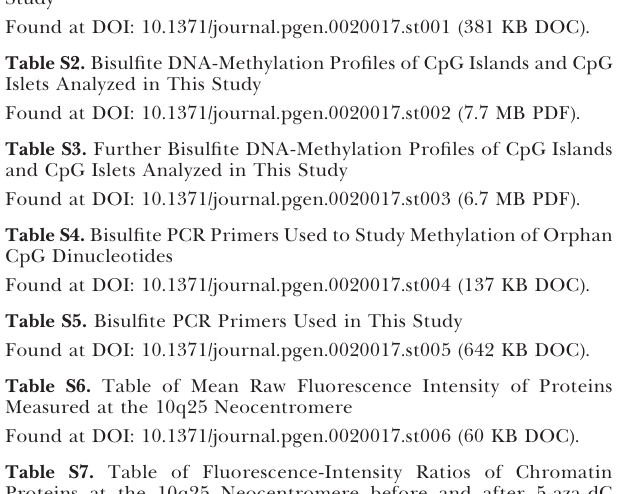
Table S1. Table of Control CpG Islands and CpG Islets Used in This Study Table S2. Bisulfite DNA-Methylation Profiles of CpG Islands and CpG Islets Analyzed in This Study Table S3. Further Bisulfite DNA-Methylation Profiles of CpG Islands and CpG Islets Analyzed in This Study Table S4. Bisulfite PCR Primers Used to Study Methylation of Orphan CpG Dinucleotides Table S5. Bisulfite PCR Primers Used in This Study Table S6. Table of Mean Raw Fluorescence Intensity of Proteins Measured at the 10q25 Neocentromere Found at DOI: 10.1371/journal.pgen.0020017.st006 (60 KB DOC). Table S7. Table of Fluorescence-Intensity Ratios of Chromatin Proteins at the 10q25 Neocentromere before and after 5-aza-dC Treatment Table S8. Bisulfite PCR Primers Used for Control Regions in This Study Found at DOI: 10.1371/journal.pgen.0020017.st008 (63 KB DOC). Table S9. Genome-Wide CpG Islet Annotations in 100, 200, and 400- bp Window Sizes Formatted for upload as a custom annotation track into the May 2004 (hg17) reference sequence from the UCSC Genome Browser